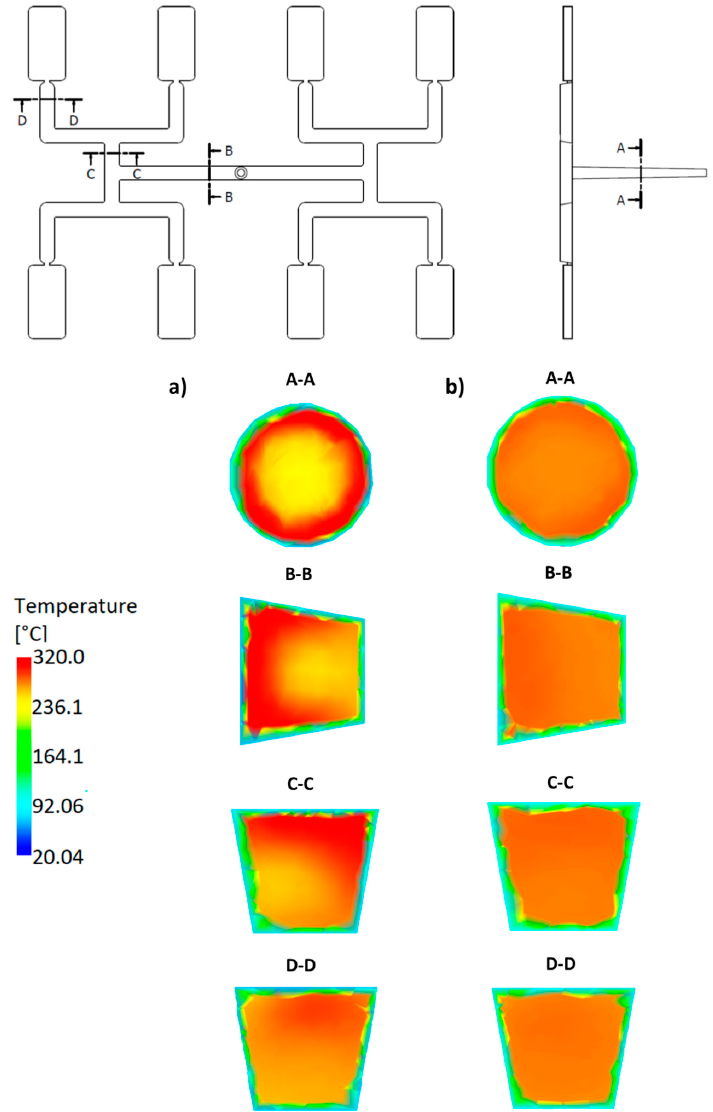
Figure 21. Temperature distribution in the selected cross-sections of the runners for different relaxation time at high injection rate in the case of the standard geometry GS : ( a ) λ = 0.001 s ( I m = 20%), and ( b ) λ = 0.1 s ( I m = 1%).